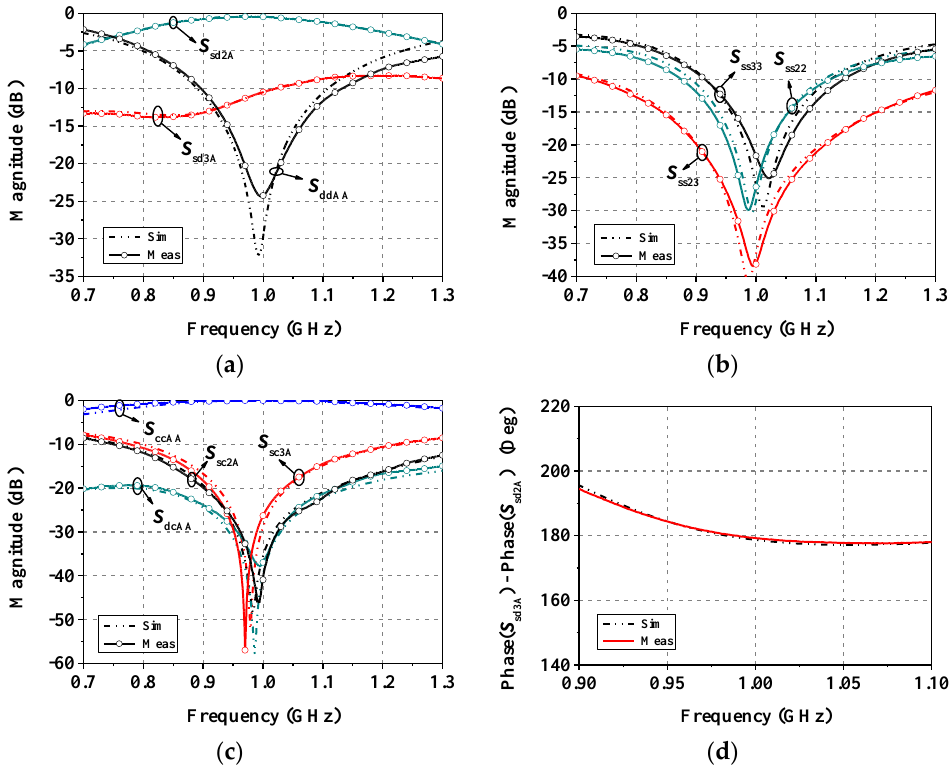
Figure 6. Performances of the proposed 10-dB BTU power divider. ( a ) | S sd2A |, | S sd3A |, and | S ddAA |. ( b ) Output ports isolation and return loss. ( c ) | S ccAA |, | S sc2A |, | S sc3A |, and | S dcAA |. ( d ) Phase difference between the output ports.